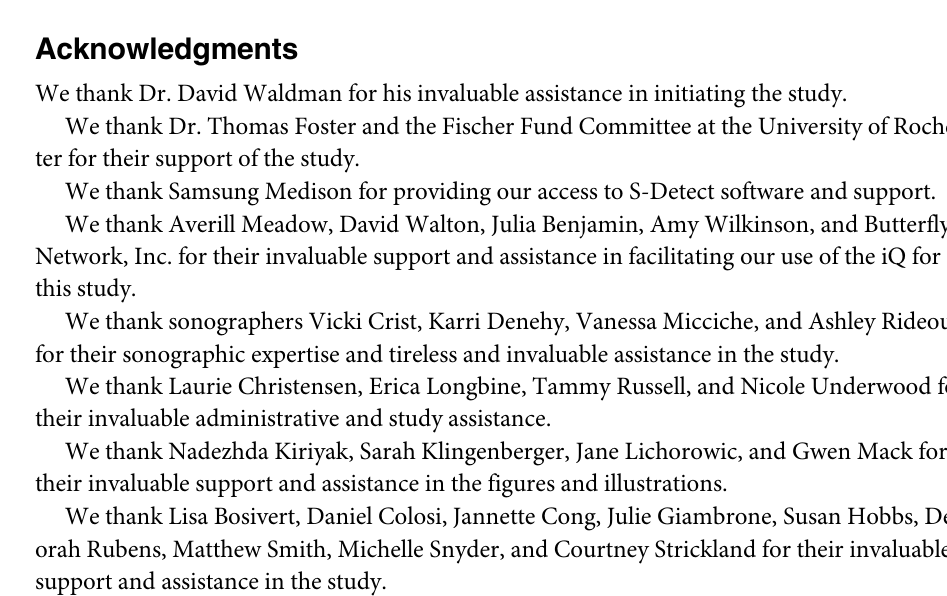
S1 Table. Agreement on mass characteristics between S-Detect interpretation of VSI, com- pared to other interpretations, sub-divided by the masses included in the